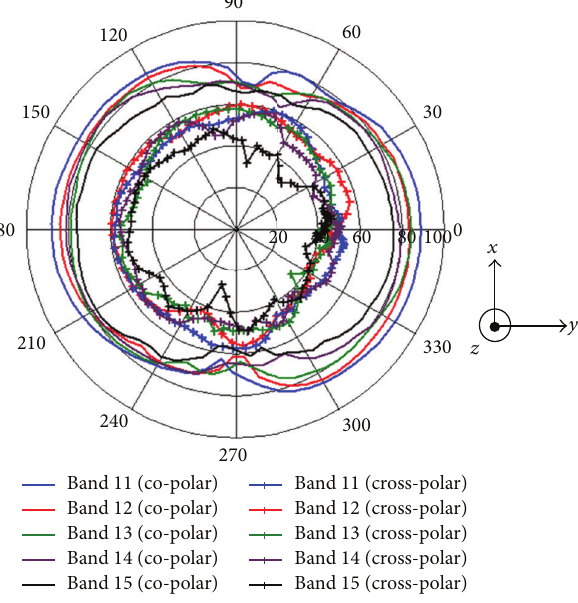
Figure 8: Measured E-plane radiation patterns (co-polar & cross- polar) at operating frequency, 𝑓 , for TMFDB25 with stubs 1, 2 at bands 6 to 10.